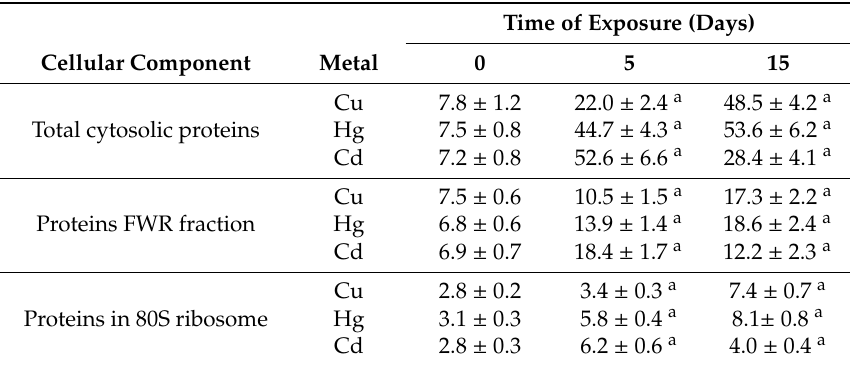
and exposed mussels to 40 µ g / L Cu, 30 µ g / L Hg, or 100 µ g / L Cd for 5 or 15 days.